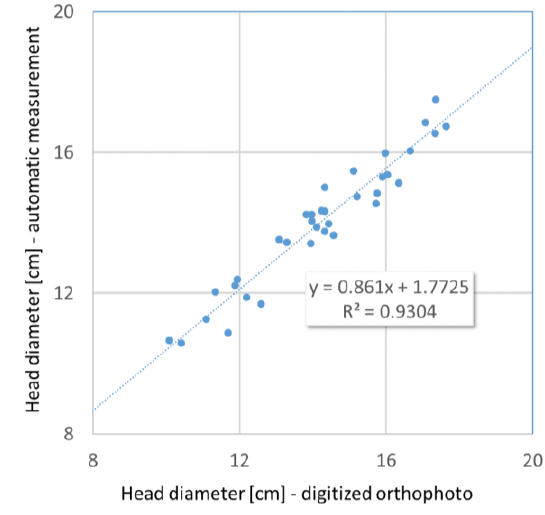
Figure 9: Regression between the automatically measured and digitized head diameters (N = 35 lines (245 individual